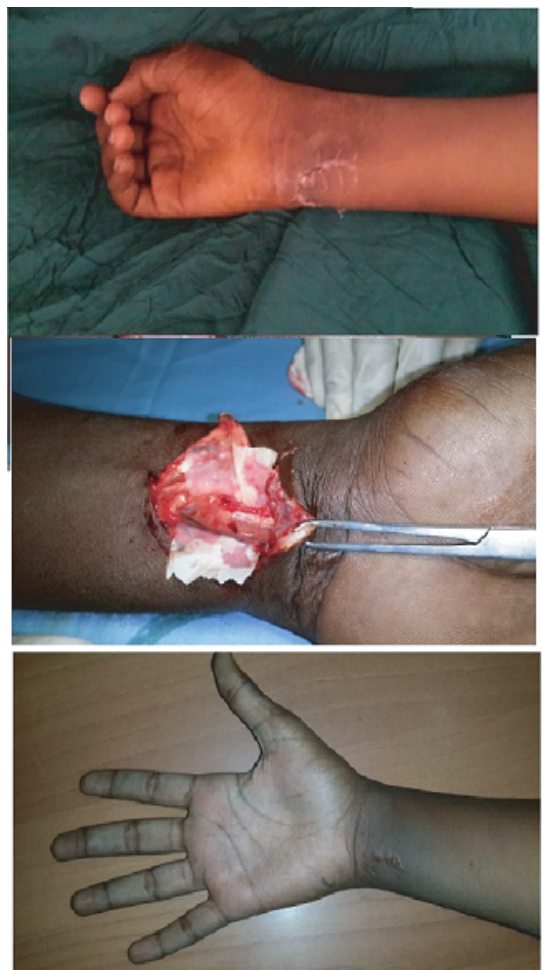
Figure 2 : Nerve injury and